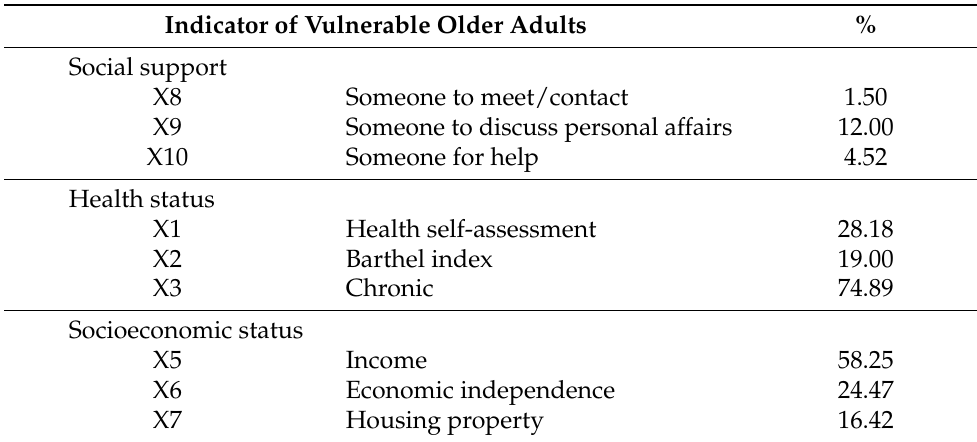
Table 4. Distribution of items measuring multiple dimensions of vulnerable older adults (N =